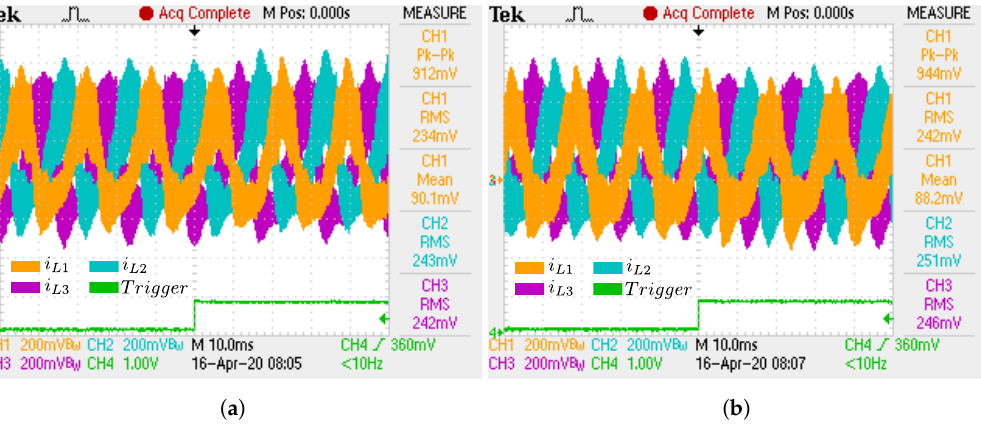
Figure 35. Experimental Inductor currents for RL transition load: ( a ) First transition; ( b ) Second